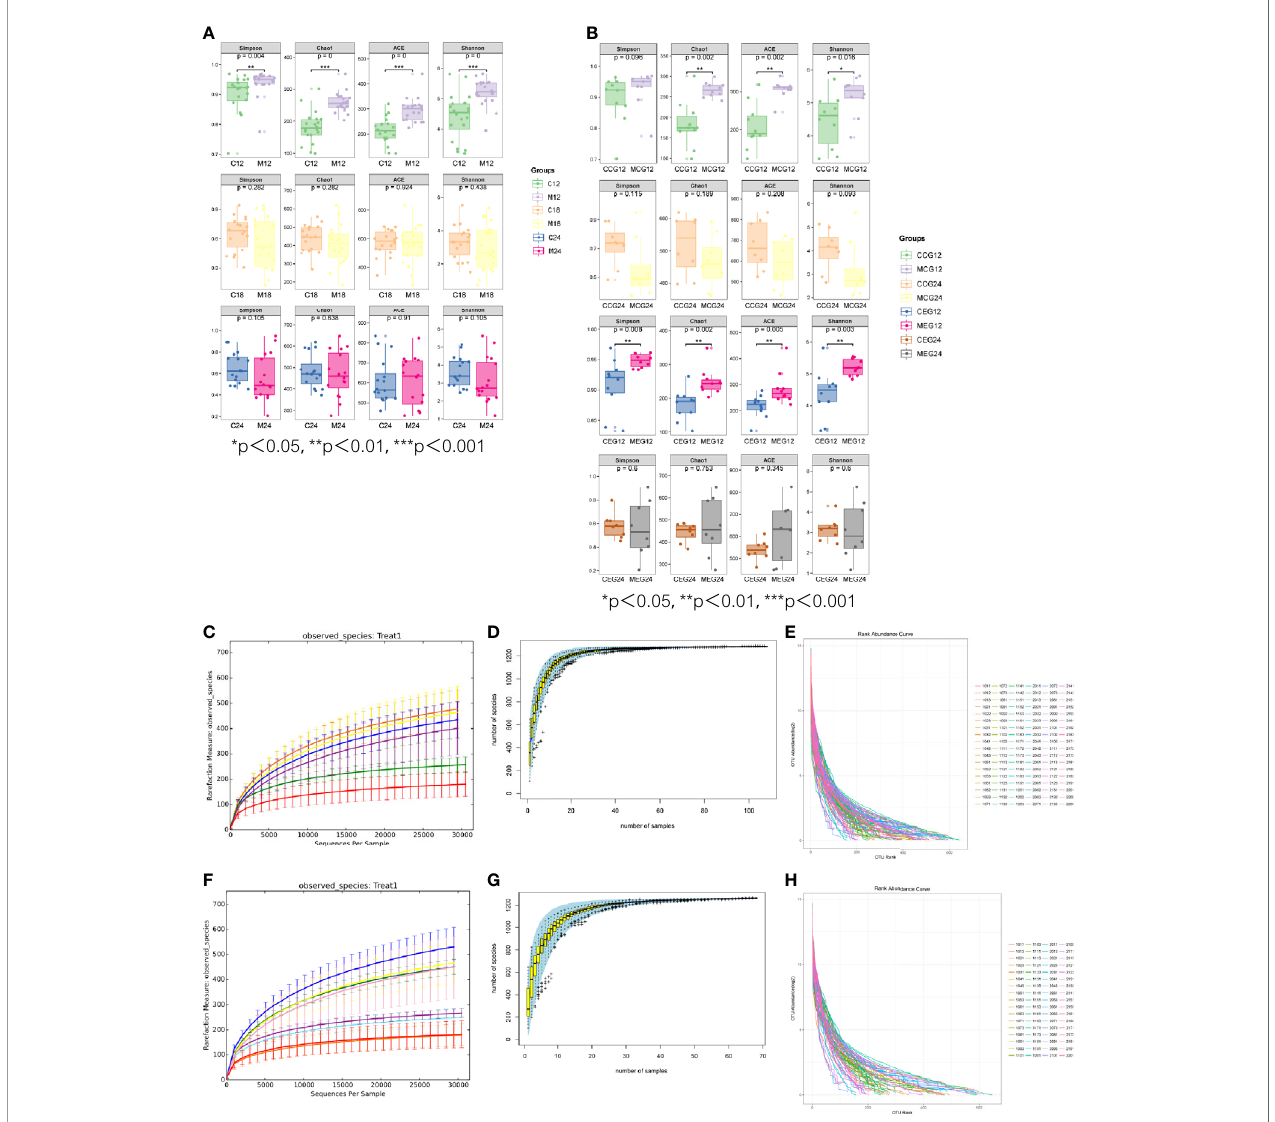
FIGURE 2 | The alpha diversity indices of different groups. (A) The alpha diversity indices (Chao1, Shannon, Simpson, and ACE) between mother (M) and child (C) at 12, 18, and 24 months of age. (B) The alpha diversity indices (Chao1, Shannon, Simpson, and ACE) between M and C in the exposure group (MEG and CEG) and the control group (MCG and CCG) at 12 and 24 months of age. The rarefaction curves (C, F) , species accumulation curves (D, G) and abundance distribution curves (E, H) for